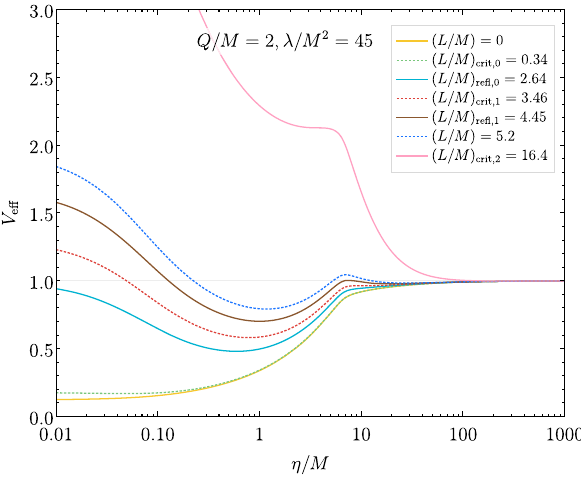
Fig. 27 Same as Fig. 25 for parameters Q / M = 2, λ/ M 2 = 45